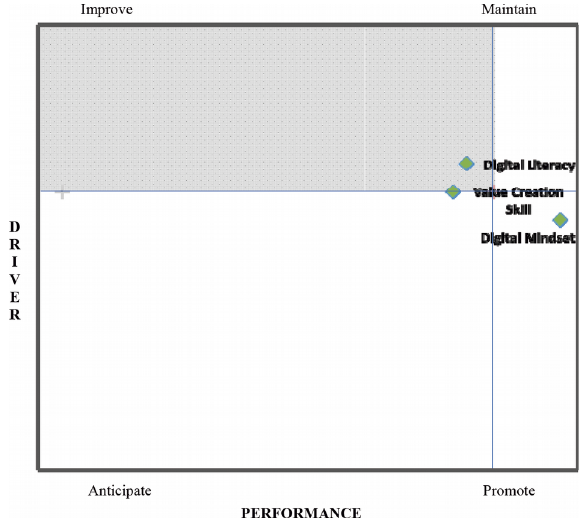
Figure 9. Individual Capability Quadrant Analysis